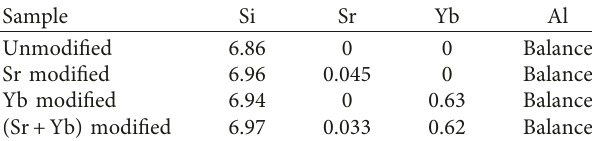
Table 1: Targeted compositions of the experimental alloys